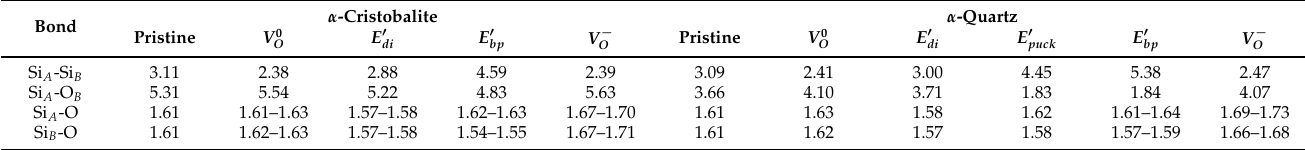
Table 2. Bond length (Å) between the atoms surrounding the oxygen vacancy: Si A , Si B , O B and O surrounding the Si A / B atoms in α -C and α -Q. For some Si A / B -O bond lengths a range is reported as the bond lengths slightly differ due to asymmetries in the relaxation around the defect. The atoms and labeling conventions are described in Figures 3–5. α -cristobalite and α -quartz are compared to understand how they are perturbed between each defect.